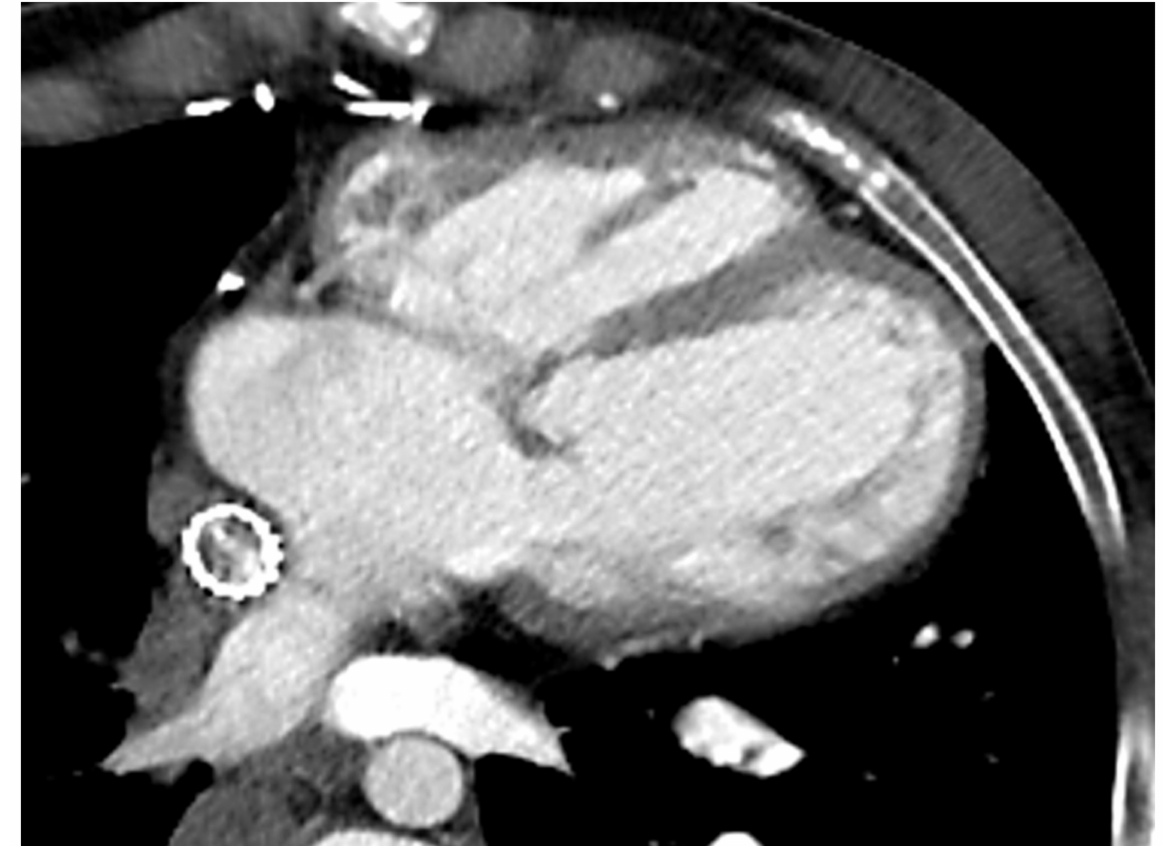
Figure 4. Cardiac CT in Fontan patient with stenting of the extracardiac